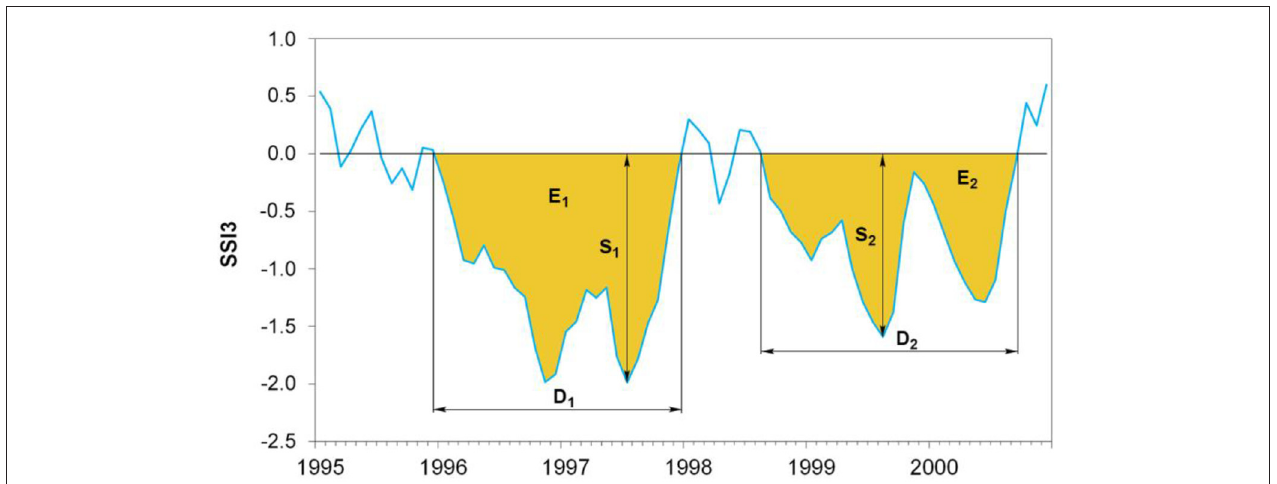
FIGURE 3 | Temporal evolution of the SSI3 for the Mendoza River between January 1995 and December 2000 and the main hydrological drought characteristics. E n , event n ; D n , duration of the event n ; S n , severity of the event n ( n